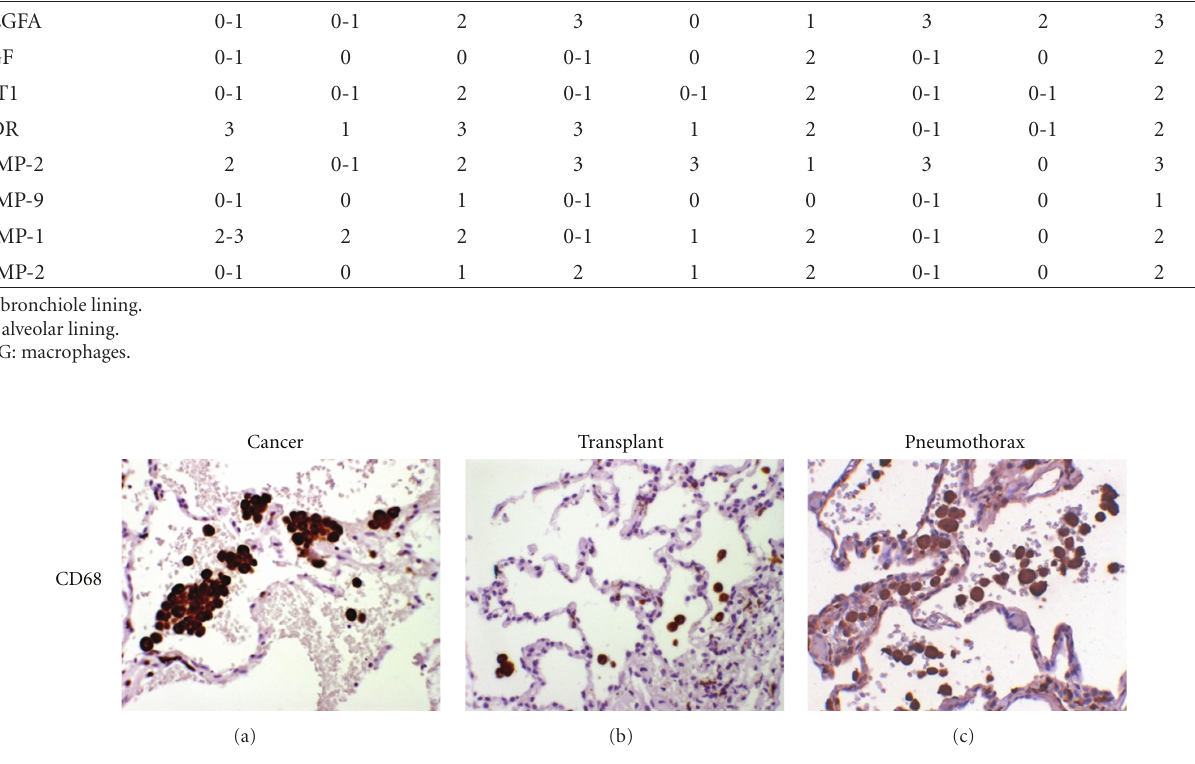
Table 3: Immunoreactivity scores for antibodies in lung derived from cancer resection, transplant biopsy, and pneumothorax. Antibody